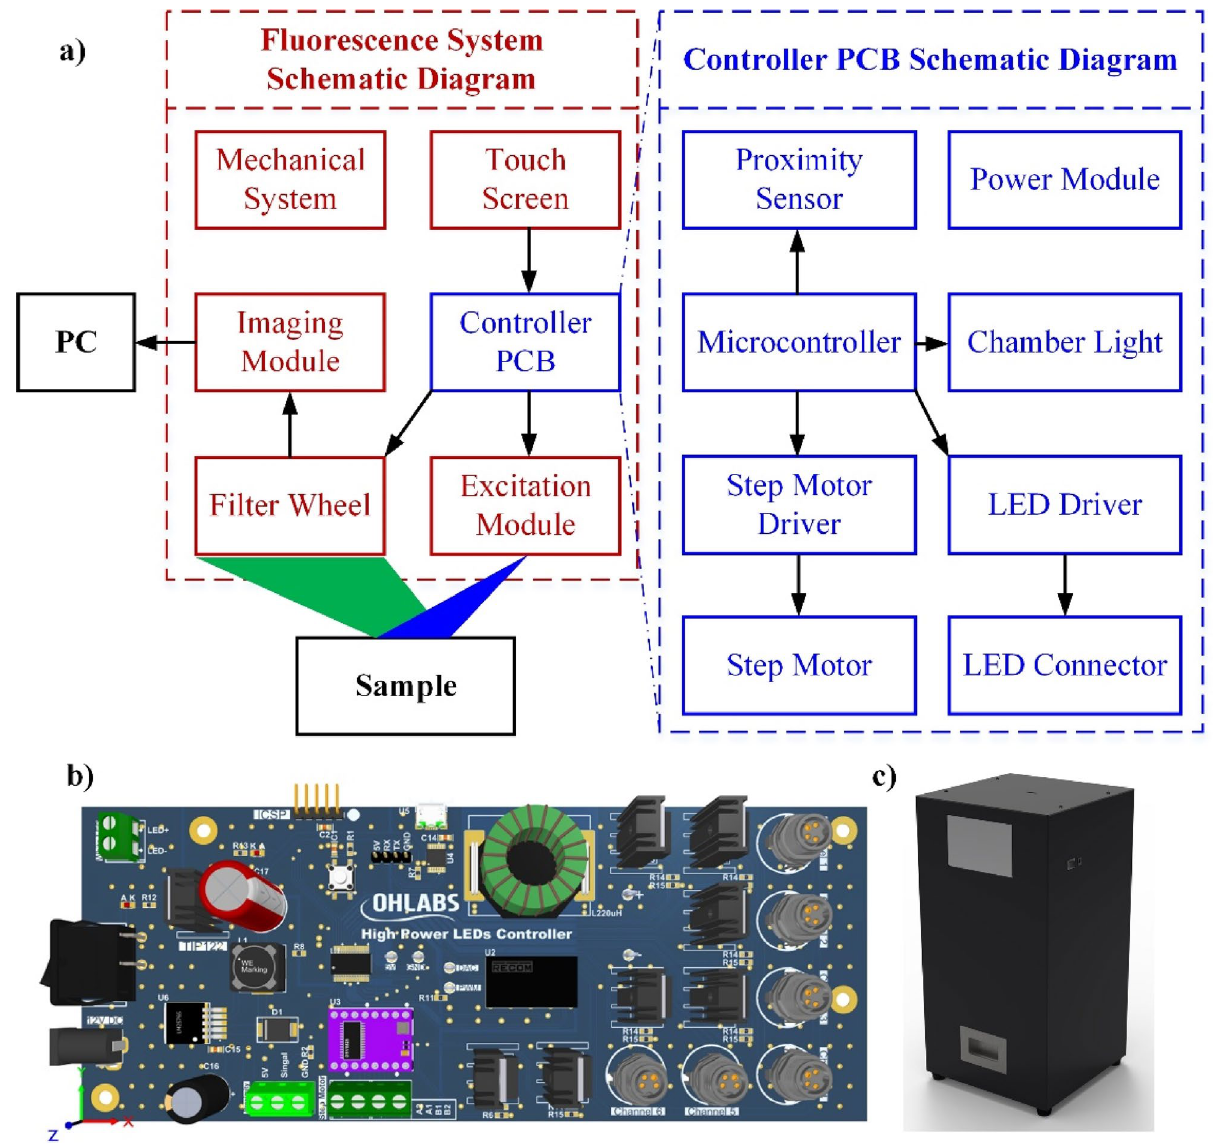
Figure 9. The proposed fluorescence imaging system ( a ) Schematic diagram of fluorescence system and the controller printed circuit board (PCB) ( b ) 3D design of controller PCB ( c ) 3D design of fluorescence